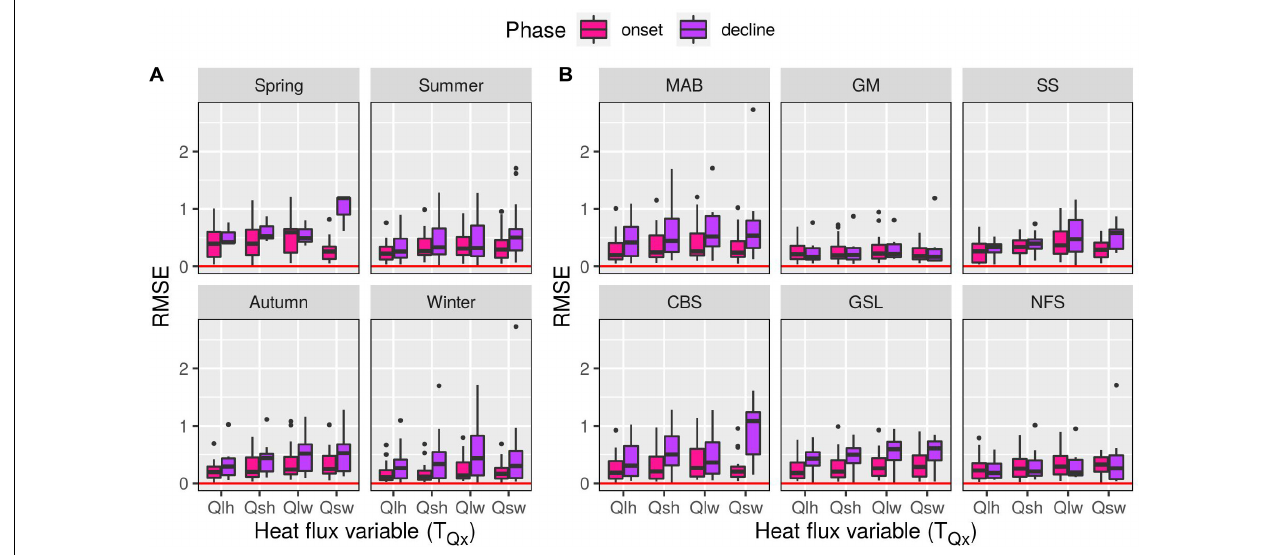
FIGURE 3 | Boxplots showing the range of RMSE values for the T Qx variables grouped by (A) season and (B) region. The horizontal red line shows a value of 0, which would mean that the daily changes of SSTa and T Qx are the same. Note that lower RMSE values are better, so the closer to the horizontal red lines the boxplots are, the better that T Qx variable explains daily changes in SSTa.